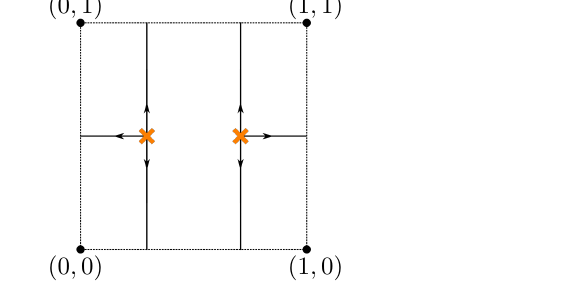
Figure 14 . Topology of the Stokes graph corresponding to the accumulation ray. There are two double walls which lift to γ 1 + γ 2 and one that lifts to γ 3